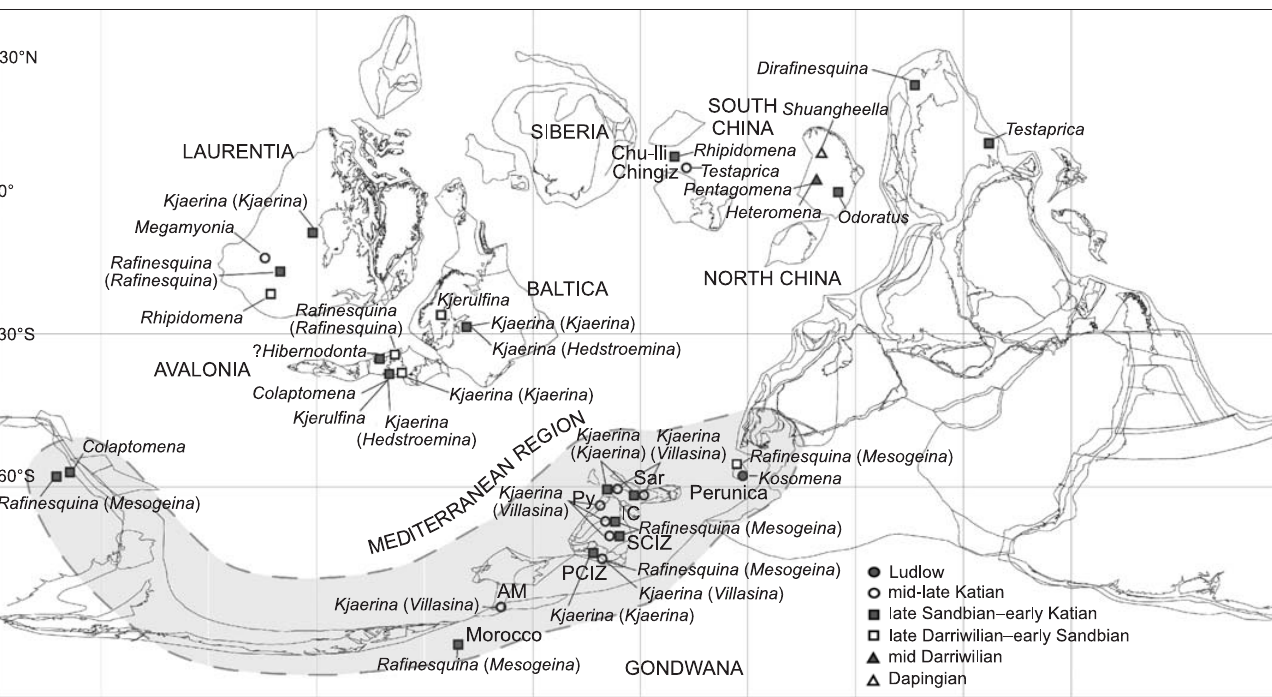
Fig. 20. First Appearance Datum (FAD) of all rafinesquinine genera in each palaeocontinent plotted over a palaeogeographical map for the late Katian time slice based on BugPlates and using a Mollweide projection. Present-day outlines of lands and seas are shown on each continent to aid recognition. AM, Armorican Massif; PCIZ, Portuguese Central Iberian Zone; SCIZ, Spanish Central Iberian Zone; IC, Iberian Chains; Py, Pyrenees; MN, Montagne Noire; Sar,